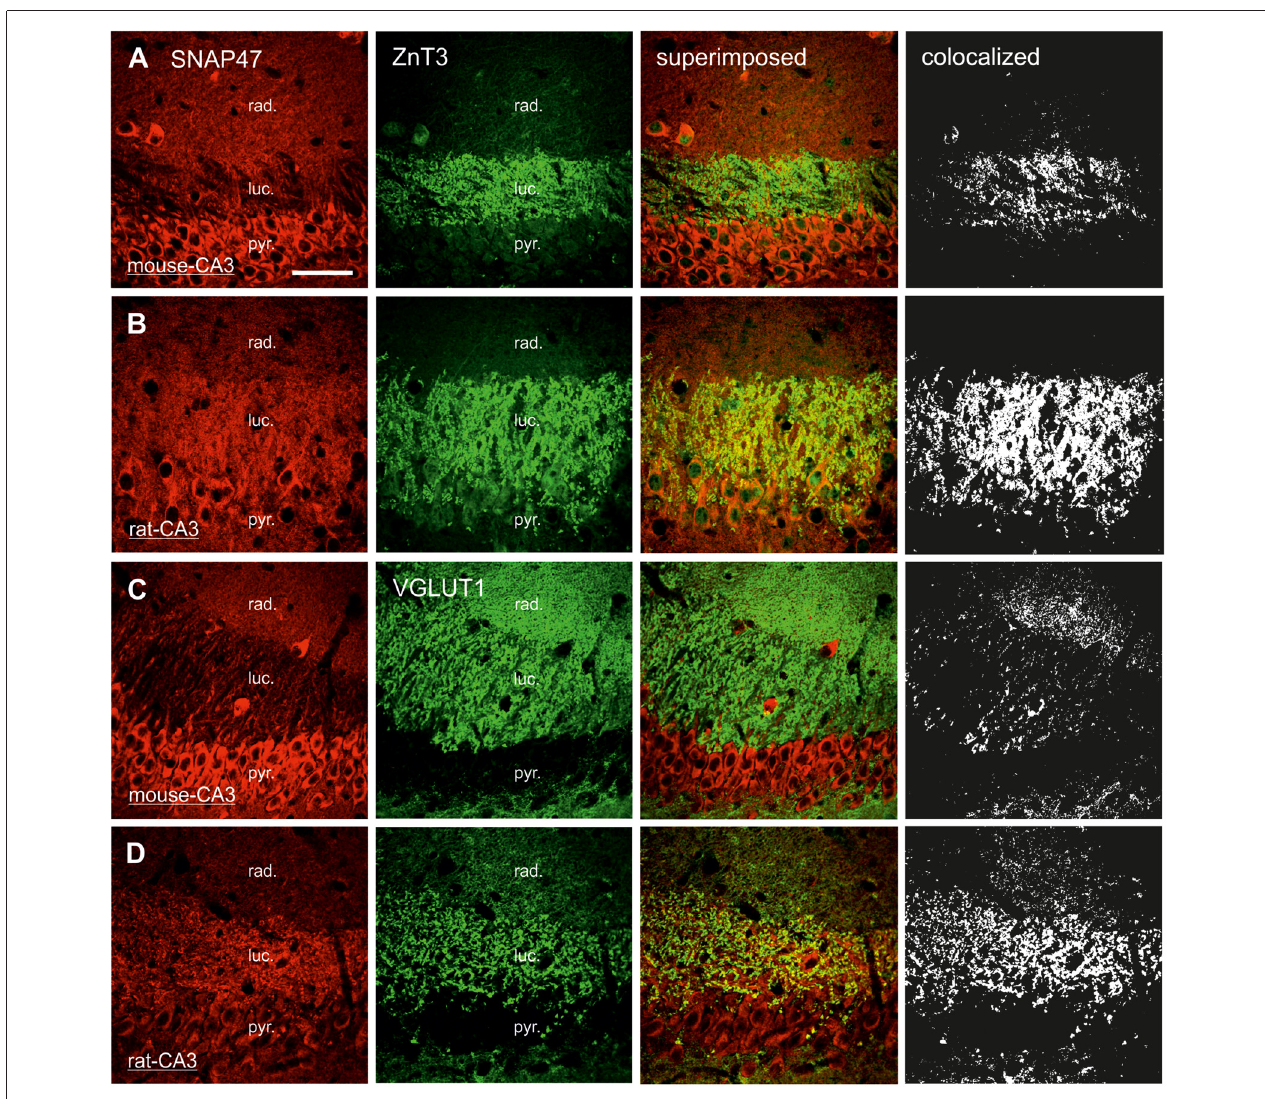
FIGURE 8 | Presynaptic localization of SNAP47 in the CA3 area of mouse and rat hippocampus. (A) Confocal images of the co-localization of SNAP47 (red pseudocolor, left) and the presynaptic marker ZnT3 (in green, middle left) in the CA3 area of the mouse hippocampus. Note that SNAP47 shows weak labeling and weak co-localization with ZnT3 in the stratum lucidum corresponding to the mossy fiber (MF) terminals (see the superimposed signals and the colocalization on the rigth). (B) Confocal images of the co-localization of SNAP47 and the presynaptic marker ZnT3 in the CA3 area of rat hippocampus. The labeling for SNAP47 is strong in the stratum lucidum and shows substantial overlap with ZnT3. (C) Sections double stained against SNAP47 (red pseudocolor) and the presynaptic marker vesicular glutamate transporter 1 (VGLUT1; in green) in the CA3 area of the mouse hippocampus. (D) Sections double stained against SNAP47 and the presynaptic marker VGLUT1 in the CA3 area of the rat hippocampus. Scale bar represent, (A–D) , 50 µ